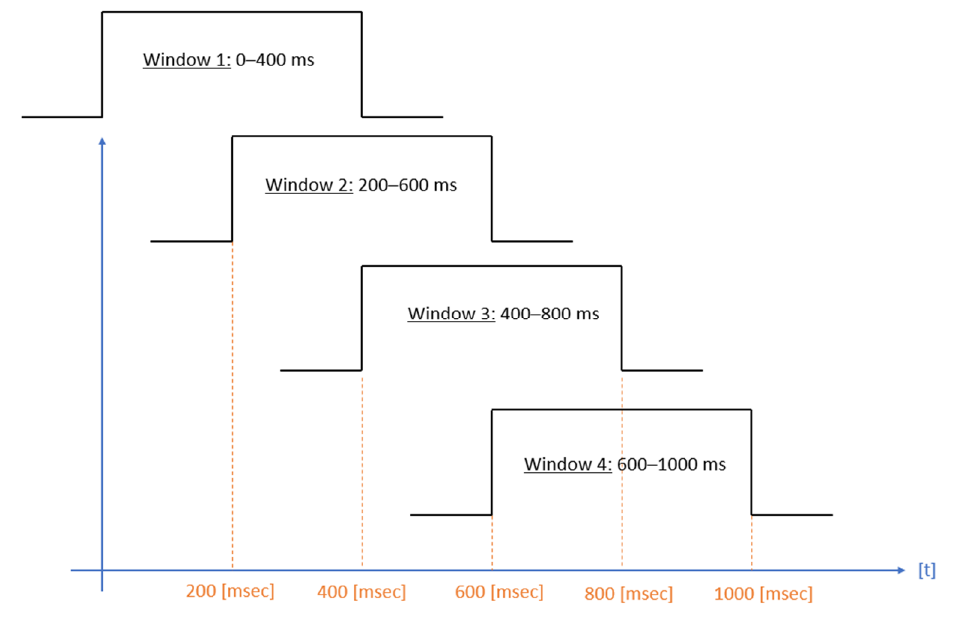
Figure A3. Baseline model windowing scheme. Table A3. Baseline model using single channel (F3)—confusion